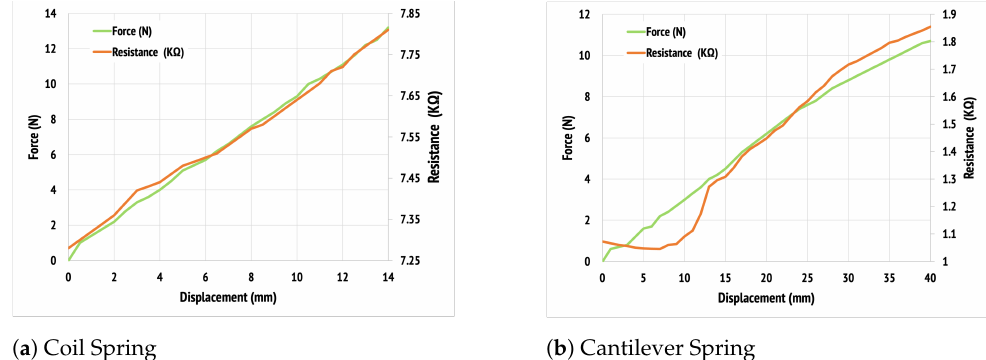
Figure 12. The results of force-displacement-resistance evaluation of coil and cantilever springs used in the proposed